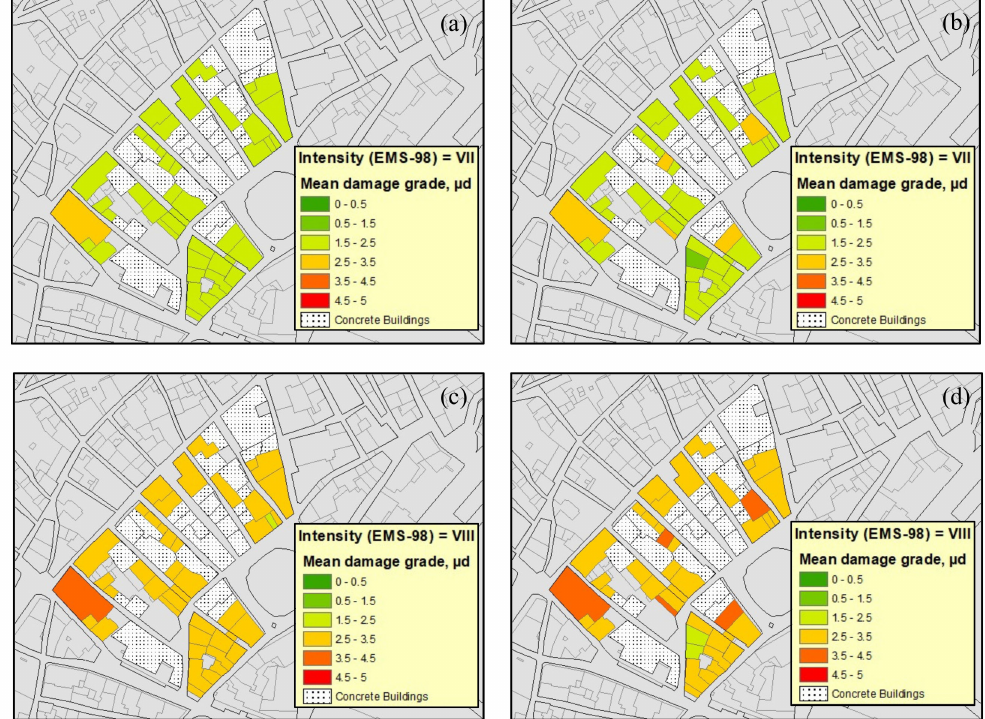
Figure 11. Damage scenario for different macroseismic intensities I EMS-98 , considering central values- ( a , c ); and reference values ( b , d ) of the Vulnerability Index I v